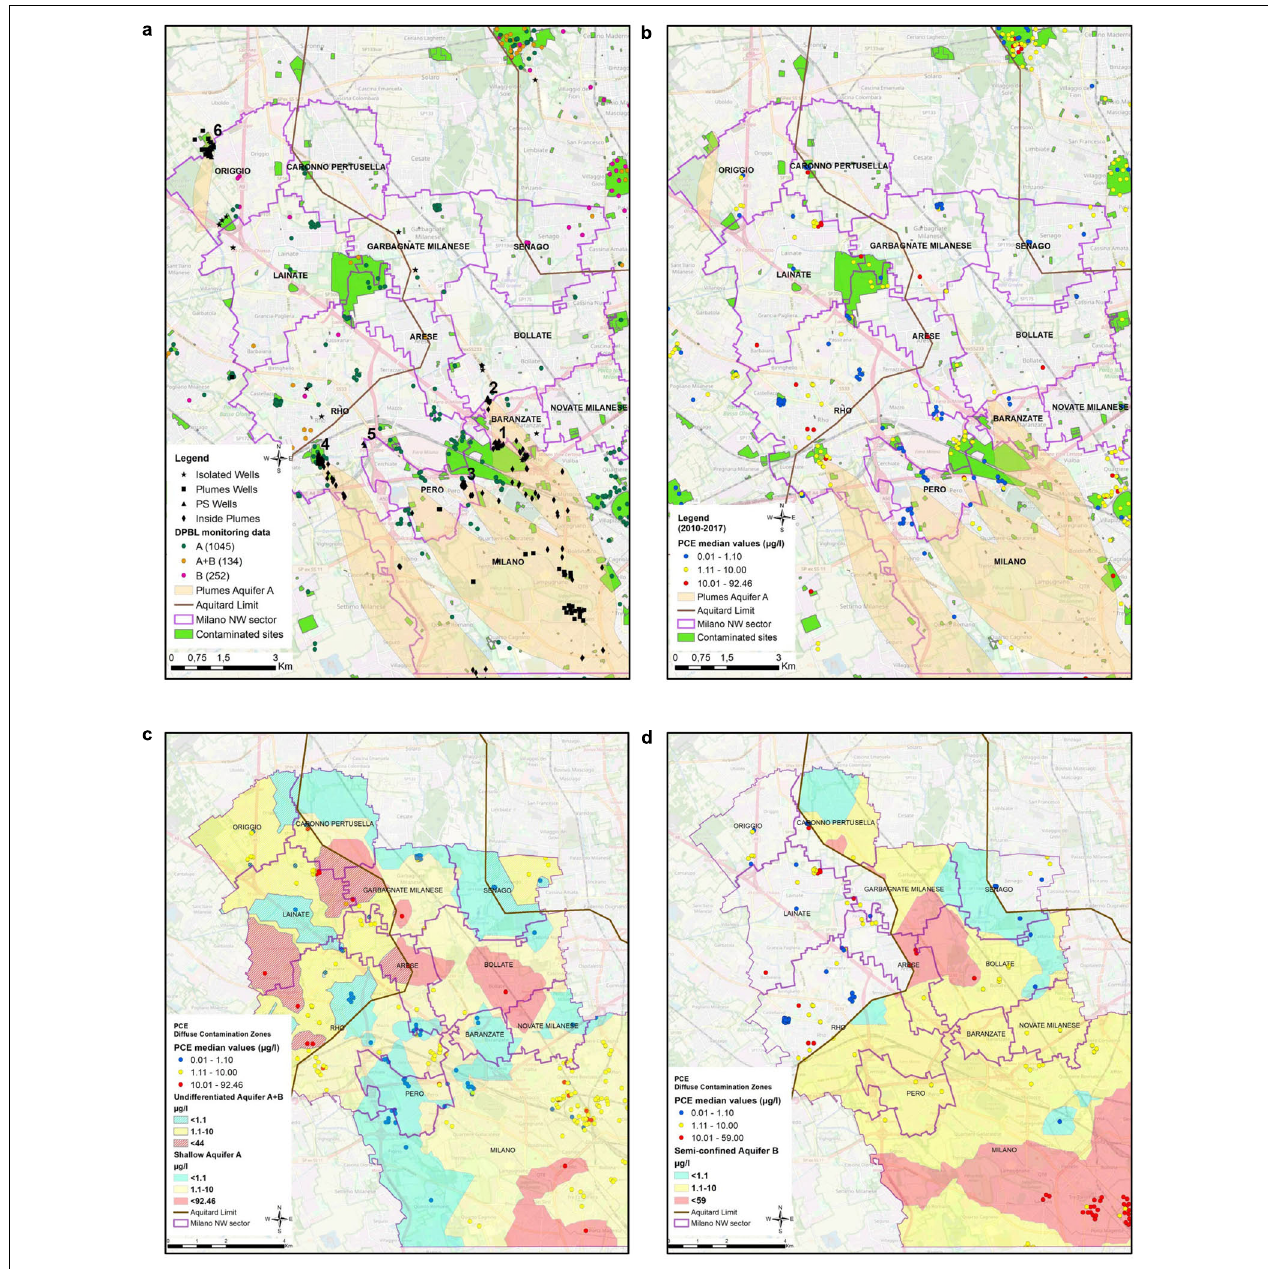
FIGURE 9 | (a) Intersection between the complete dataset and the 1.1 µ g/L isoconcentration lines of the plumes for Aquifer A; (b) representation for the shallow aquifer of median values (period 2010–2017) of the adjusted dataset used to IDW interpolation process and (c) spatial map of the diffuse contamination in the shallow/unseparated aquifer and (d) in semiconfined Aquifer